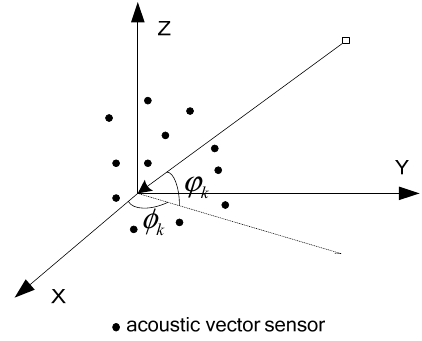
Figure 1. The structure of acoustic-vector sensor array